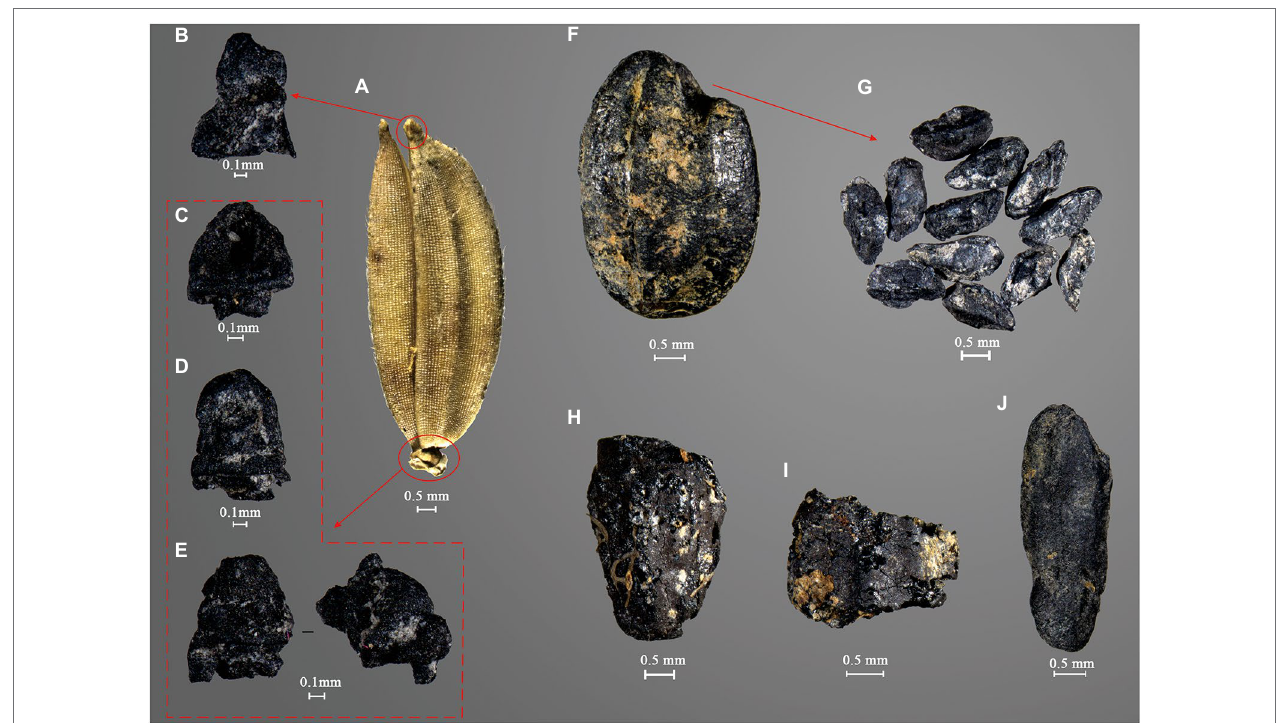
FIGURE 5 | Different types of rice remains from the Zhiwuyuan site. (A) Modern rice with husk, (B) apex of rice husk, (C) rice spikelet base (non-shattering type), (D) rice spikelet base (shattering type), (E) rice spikelet base (protruding type), (F) mature rice grain, (G) embryos of rice grain, (H) big fragment of rice grain, (I) small fragment of rice grain, and (J) immature rice